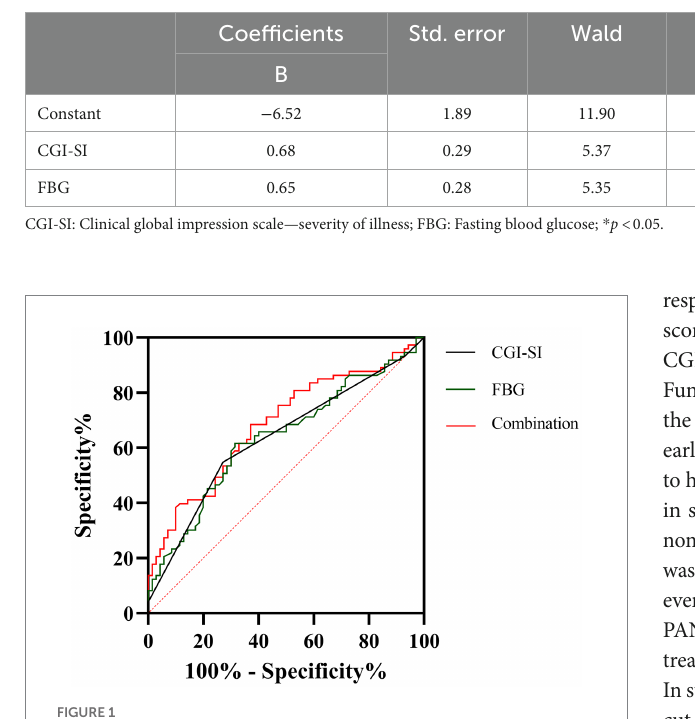
FIGURE 1 The discriminatory capacity of related factors for between early non- response and early response in including patients. The area under the curve for CGI-SI and FBG is 0.635 and 0.637, respectively.